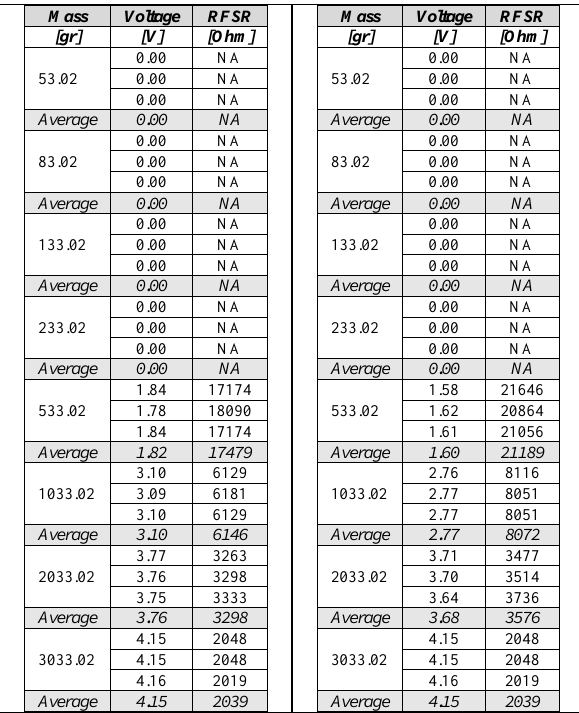
Table 8. Response of the sensor vs. the applied loads on Deep5R6 and Deep5R8 sensor housing with silicone layer (left and right panels,